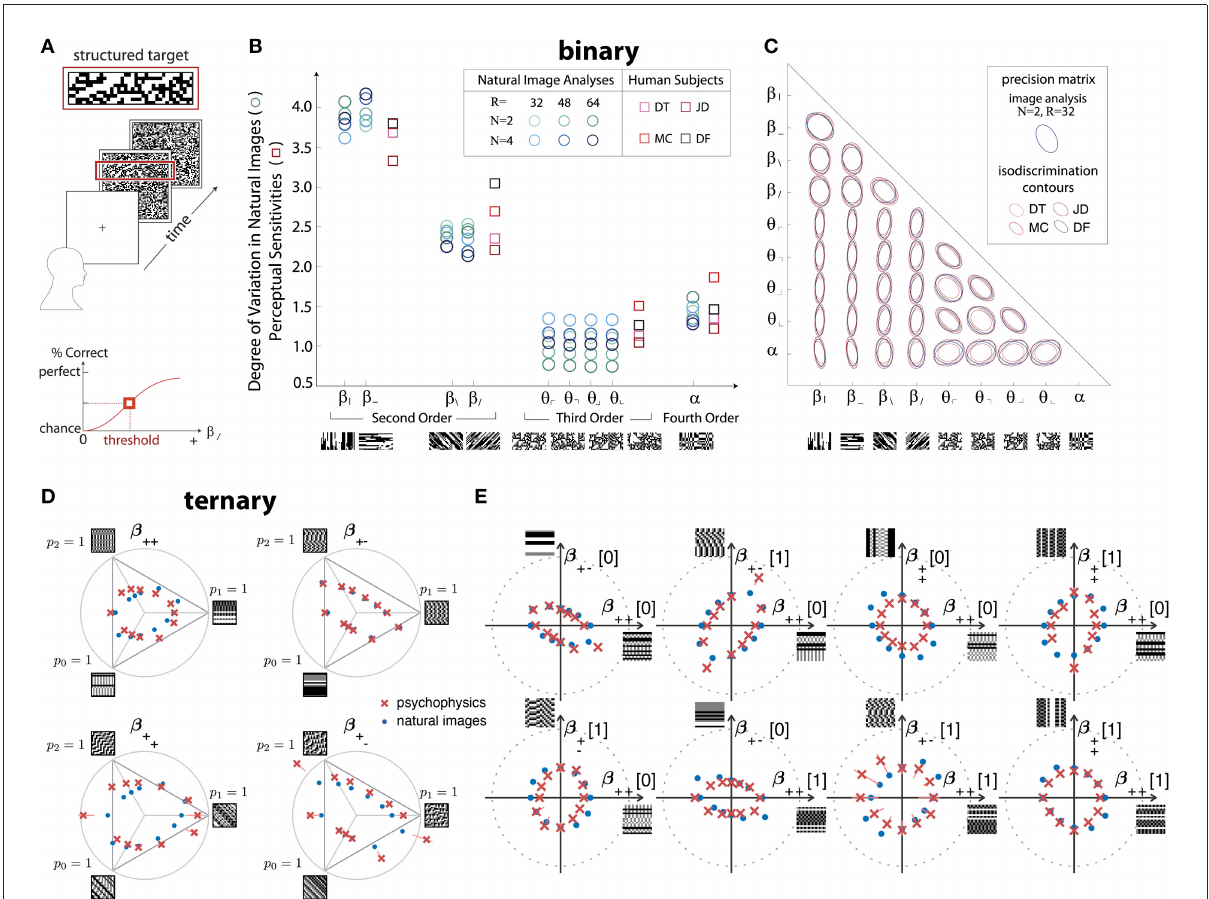
FIGURE2 Efficient coding predicts detailed psychophysical thresholds for a variety of binary and ternary textures. (A–C) Results for binary textures, adapted from Hermundstad et al. (2014). (A) The four-alternative forced-choice (4AFC) design of the experiment: after a cue, subjects are shown a background of structured (unstructured) texture with a strip of unstructured (structured) texture in one of the four cardinal positions. The subjects need to identify the location of the strip. (B) Predicted (in various shades of blue) and measured (in shades of red and purple) perceptual sensitivities for various two-, three-, and four-point correlations. Sample patches are shown under the x -axis. The different shades correspond to different preprocessing choices (for the natural-image analysis) and different subjects (for the psychophysics). (C) Predicted (blue) and measured (shades of red and purple) isodiscrimination contours for textures that combine two of the 10 axes used in (B) . (D,E) Results for ternary textures, adapted from Te¸sileanu et al. (2020). (D) Predicted (blue) and measured (red) discrimination thresholds for textures in different “simple” planes of the grayscale texture space with three gray levels. See Te¸sileanu et al. (2020) for a detailed description of the texture space. (E) Predicted (blue) and measured (red) discrimination thresholds for textures in different “mixed” planes. See Te¸sileanu et al. (2020) for a detailed description of the texture